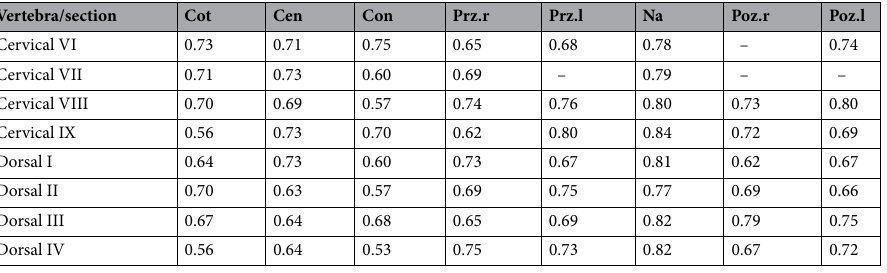
Table 1. ASP values of the analysed transverse sections of the vertebrae of SNSB/BSPG 1991 I 27. Cot, cotyle; Cen, mid-length of the centrum; Con, condyle; Prz.r, right prezygapophysis; Prz.l, left prezygapophysis; Na, mid-length of the neural arch; Poz.r, right postzygapophysis; Poz.l, left postzygapophysis. –, ASP not measured.